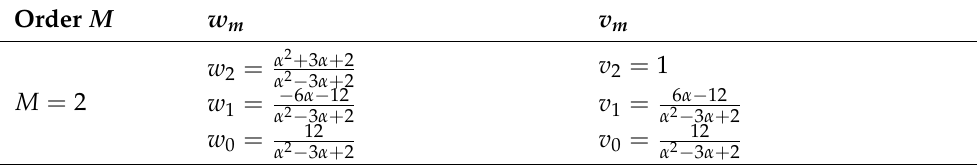
Table 2. Coefficients of CFE polynomials CFE N , D ( z − 1 , α ) for Euler approximation.